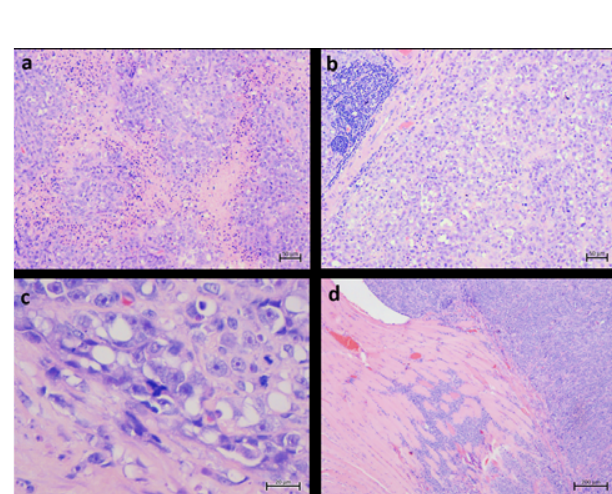
Supplementary Figure 2: Metastatic seminoma in a Southern African hedgehog. Representative images of (a) fused areas of necrosis, (b) and lymphocyte infiltration in the neoplastic mass (HE stain, bar = 50 µ m). (c) Bizarre mitosis in the neoplastic cells of the testicle (HE stain, bar = 20 µ m). (d) Neoplastic cell invasion of the diaphragm (HE stain, bar = 200 µ